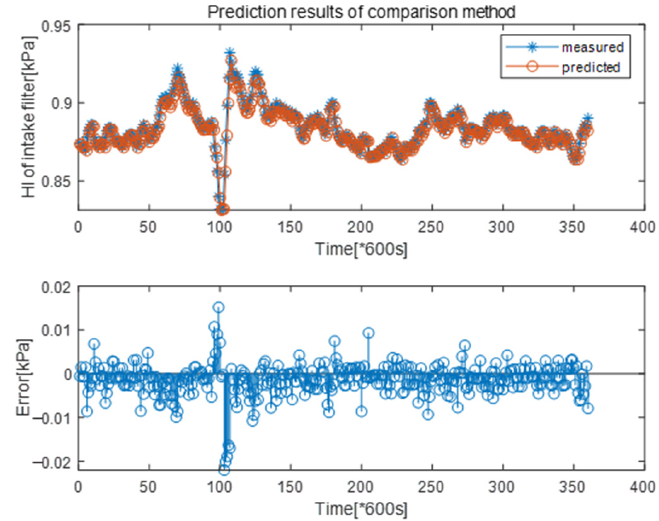
Figure 8. Performance degradation prediction results based on the PSO-SVR method.